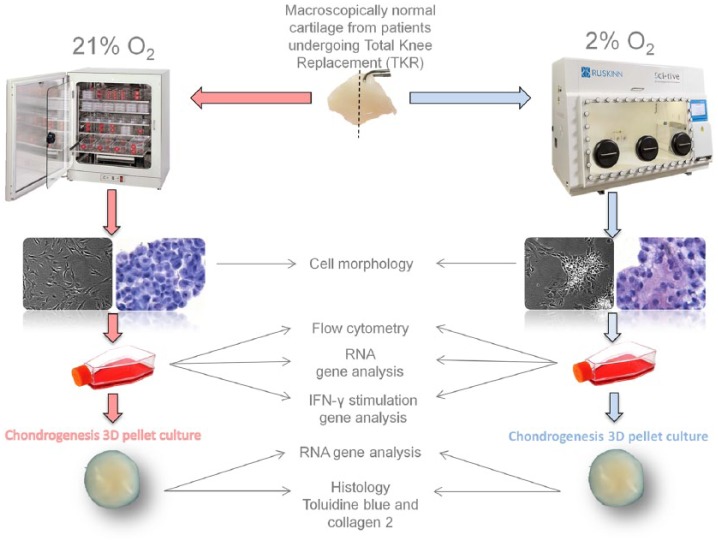
Experimental workflow. Macroscopically normal human cartilage was collected in media conditioned to 2% O2.